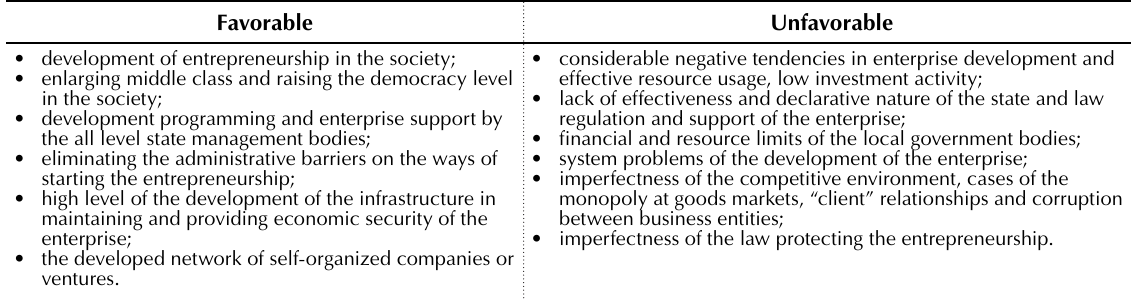
Table 2. Aspects of the economic and financial security strengthening of the enterprise Source: Developed by the authors on the basis of Blank